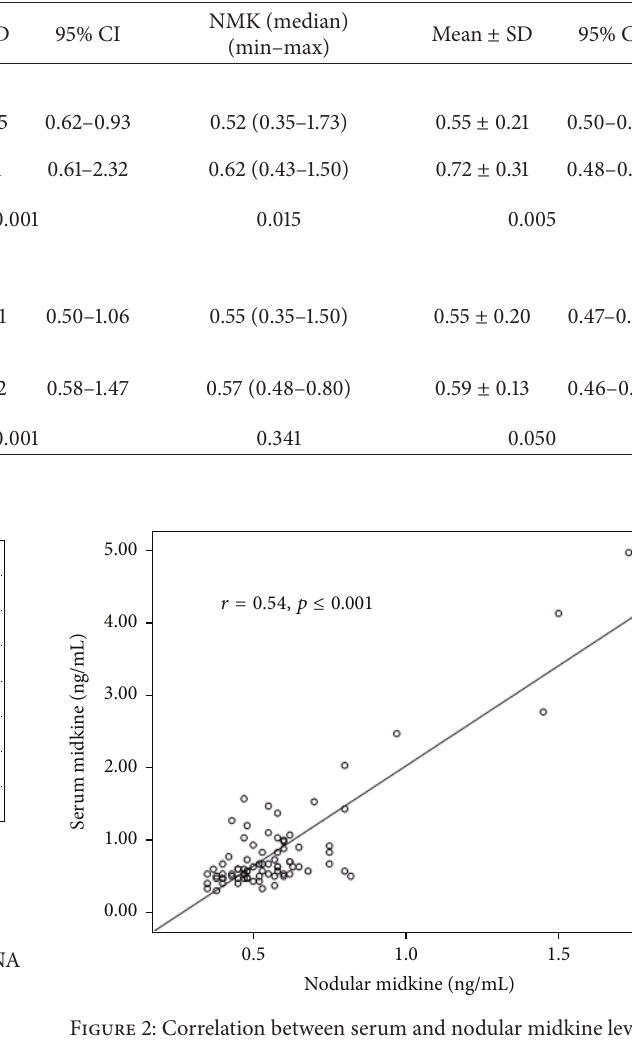
Table 3: The relationship between SMK/NMK concentrations and fine needle aspiration cytology/histopathology results.